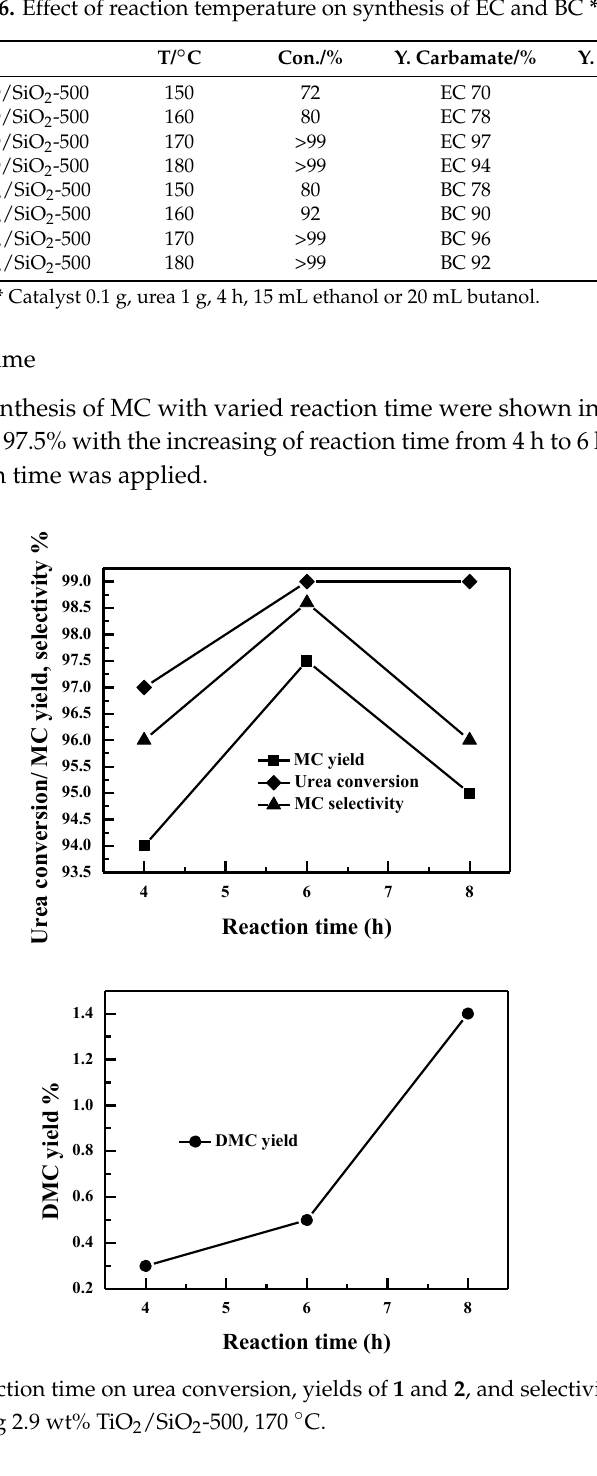
Table 7. Effect of reaction time on synthesis of EC and BC *. Catalyst